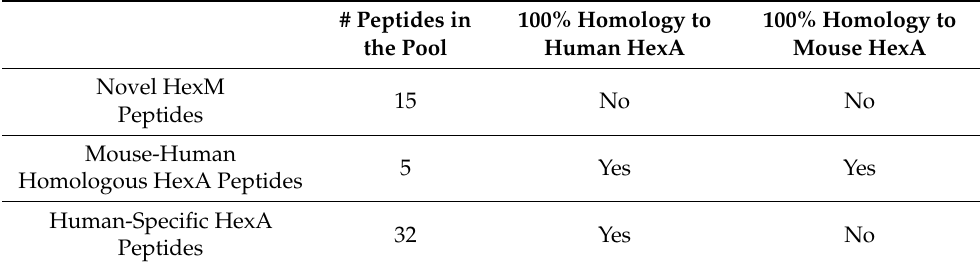
Table 3. Composition of HexM Peptide Pools.